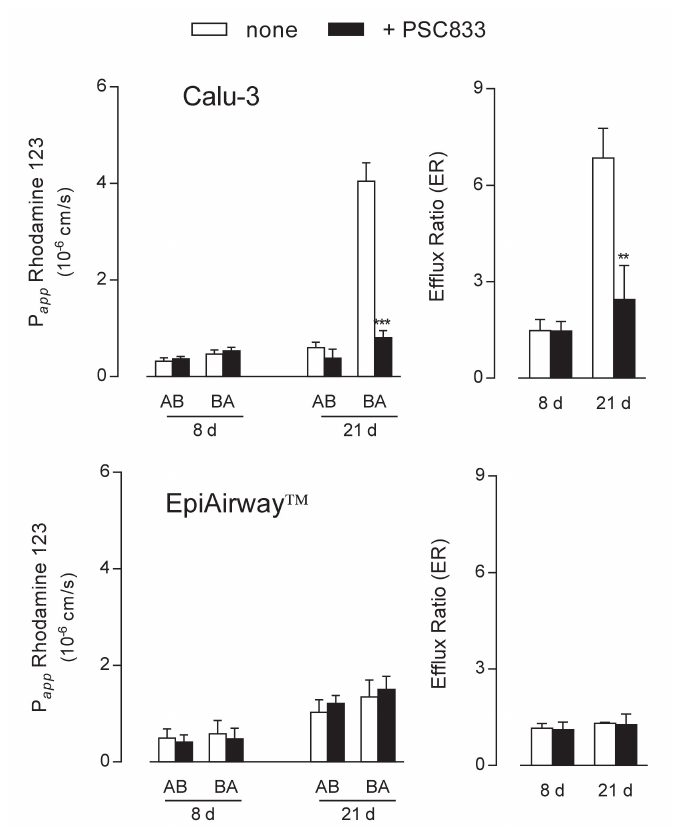
Figure 3. MDR1 activity in Calu-3 cells and EpiArway ™ maintained under ALI conditions for 8 d or 21 d. The apical-to-basolateral (AB) and basolateral-to-apical (BA) fluxes of 1 µ M Rhodamine 123 were monitored both in the absence (none) and in the presence of 10 µ M PSC833, as indicated. Data obtained were employed to calculate the e ffl ux ratio (ER), as defined in Methods. Bars represent the mean ± SEM of three independent experiments. ** p < 0.01, *** p < 0.001 vs.